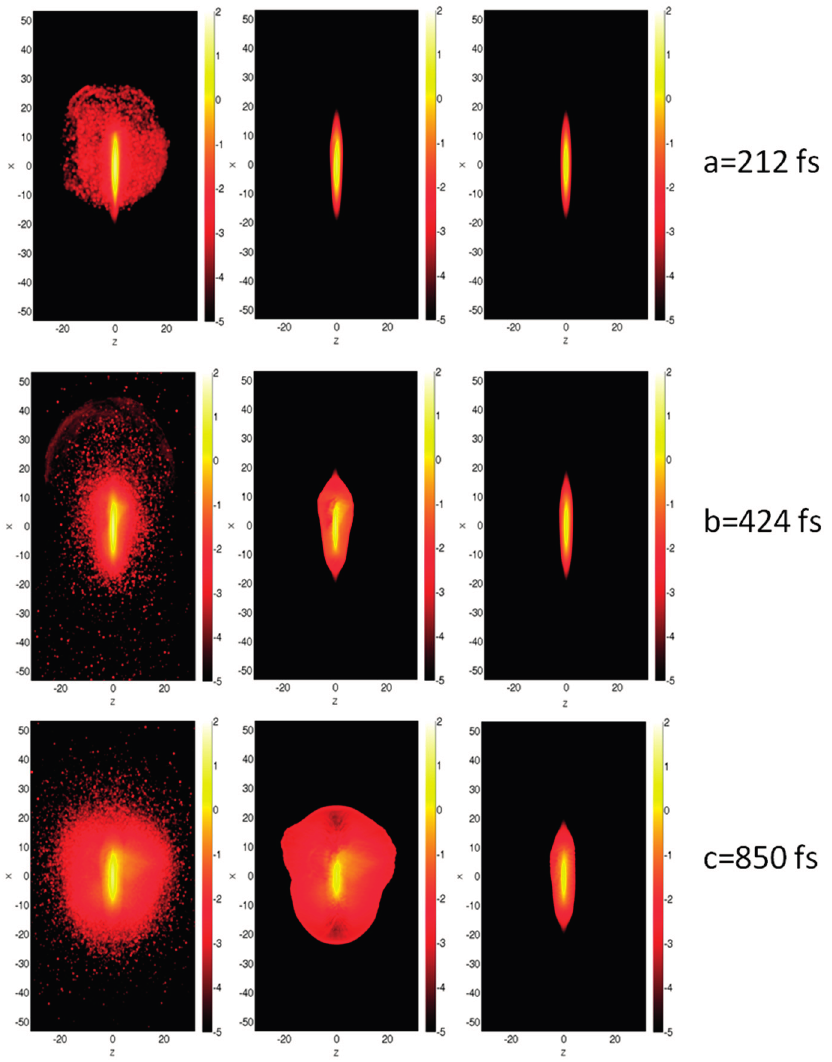
Figure 5. Spatial density distribution of electrons ( left ); protons ( middle ); oxygen ions ( right ) at times a-212 fs, b-424 fs and c-850 fs. The laser hit the whisker at 141 fs. Color map scale for density is logarithmic normalized to critical density. Vertical (x) and horizontal (z) coordinates are given in